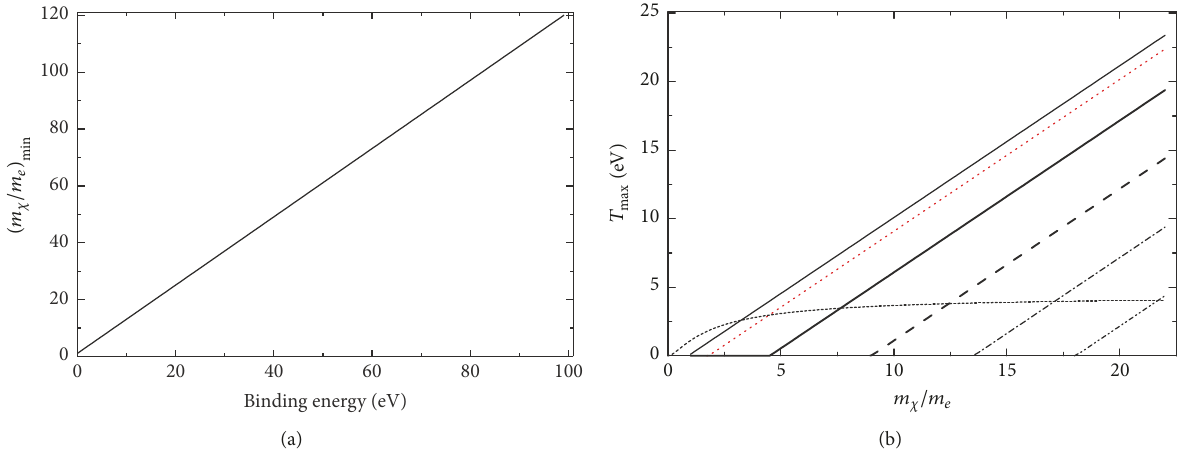
Figure 5: The minimum 𝑚 𝜒 /𝑚 𝑒 required to eject an electron with binding energy 𝑏 in eV (a). The maximum outgoing electron energy 𝑇 max as a function of 𝑥 = 𝑚 𝜒 /𝑚 𝑒 for various binding energies 𝑏 (b). In this panel the graphs correspond to 𝑏 = 1, 2, 5, 10, 15, and 20 eV from left to right. For convenience we also show again the curve which corresponds to a free electron (long dashed). It yields the same maximum electron energy for 𝑏 = 20 eV and 𝑥 =